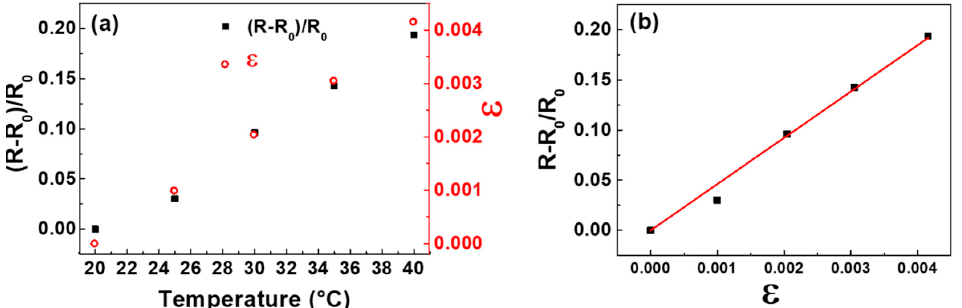
Figure 9. Fractional change of the electrical resistance, ( R − R 0 )/ R 0 , and strain, ε , versus temperature for a GNP film deposited on LDPE substrate ( a ). Fractional change of the electrical resistance, ( R – R 0 )/ R 0 , versus strain, ε , for a GNP film deposited on LDPE substrate ( b ). The straight line is the fit of the experimental data.